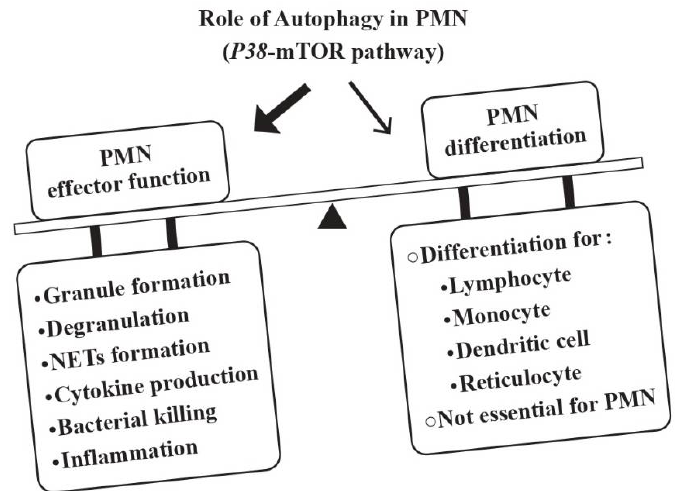
Figure 1. The roles of autophagy in the development and effector functions of PMNs. Although autophagy is essential for the ontogenetic development of lymphocytes, monocytes / dendritic cells and reticulocytes, it is not essential for neutrophils. Instead, the p 38-mTOR-induced autophagy is pivotal for developing effector functions of PMNs including granule formation, degranulation, NETs formation, cytokine production, microbial killing, and inflammation.